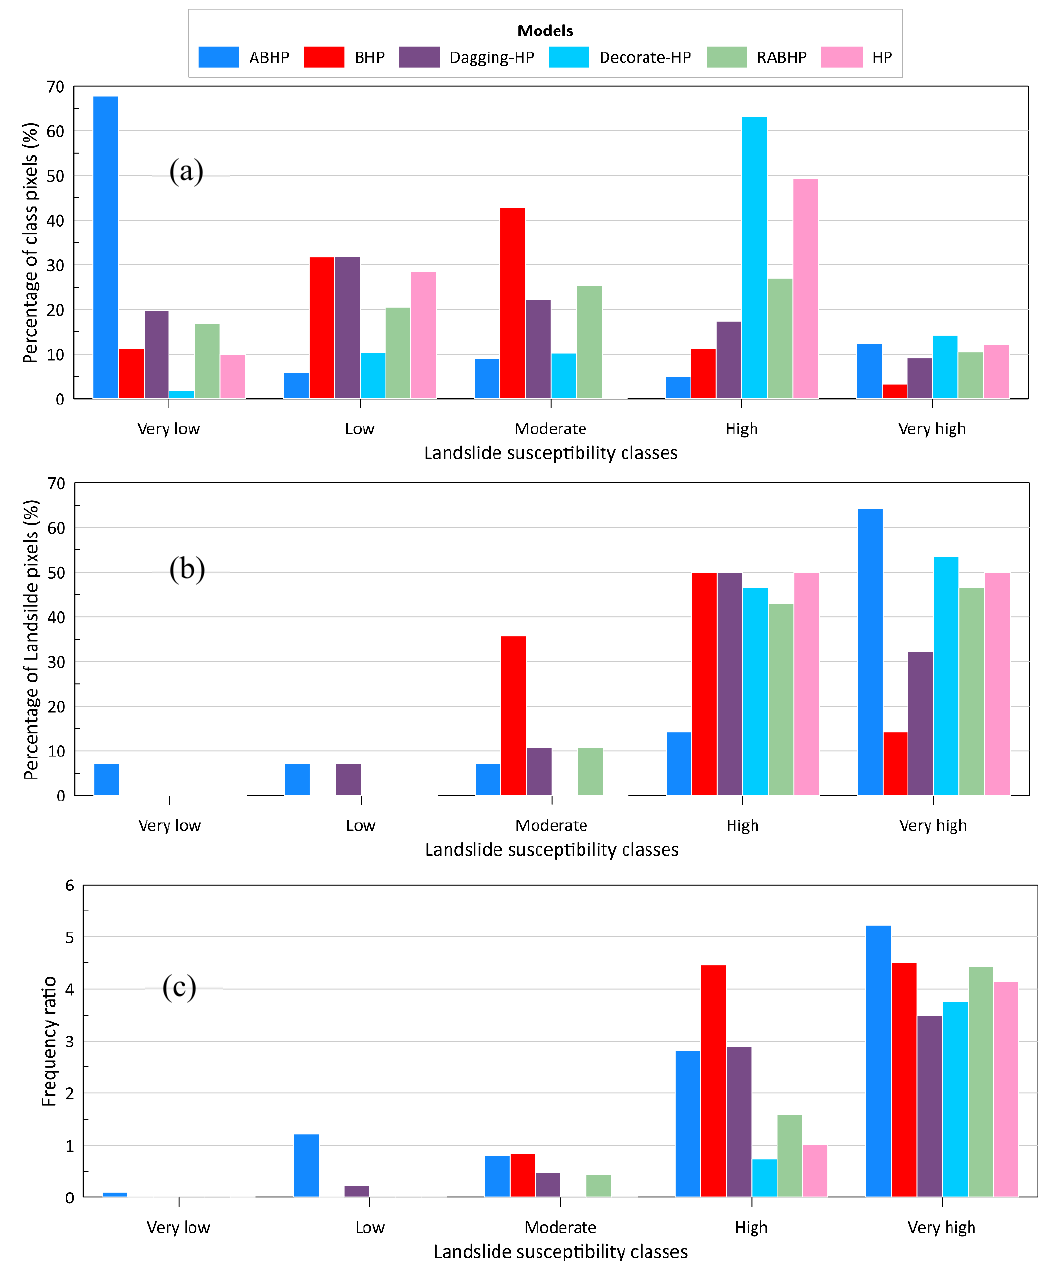
Figure 8. Frequency analysis of the landslide susceptibility maps: ( a ) percentage of class pixels, ( b ) percentage of landslide pixels, and ( c ) frequency